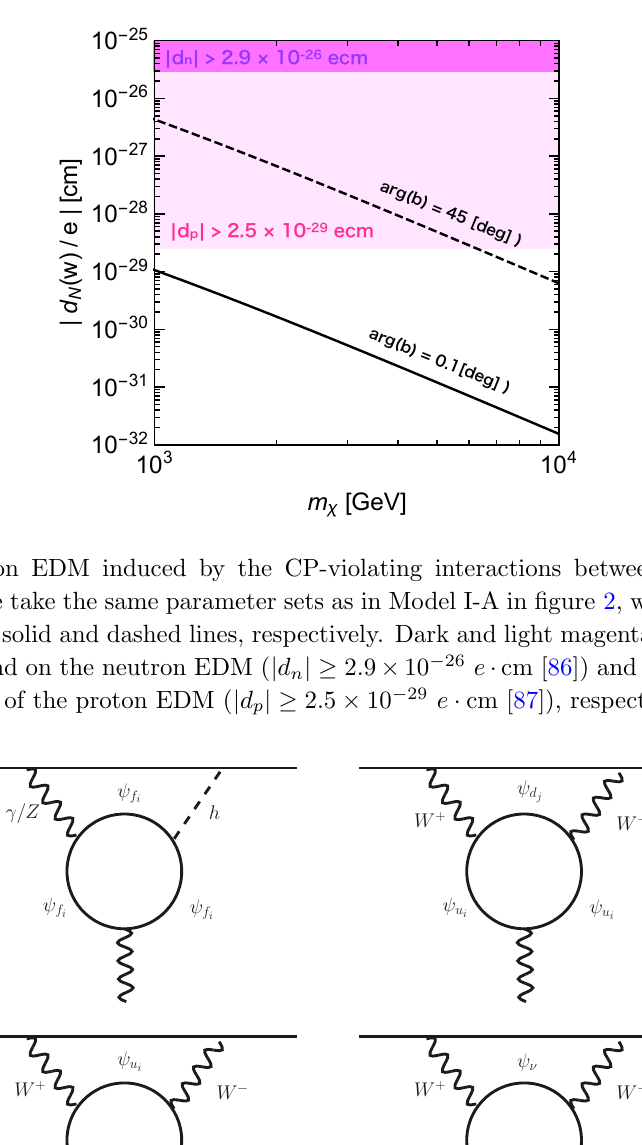
Figure 10 . Barr-Zee diagrams for electron